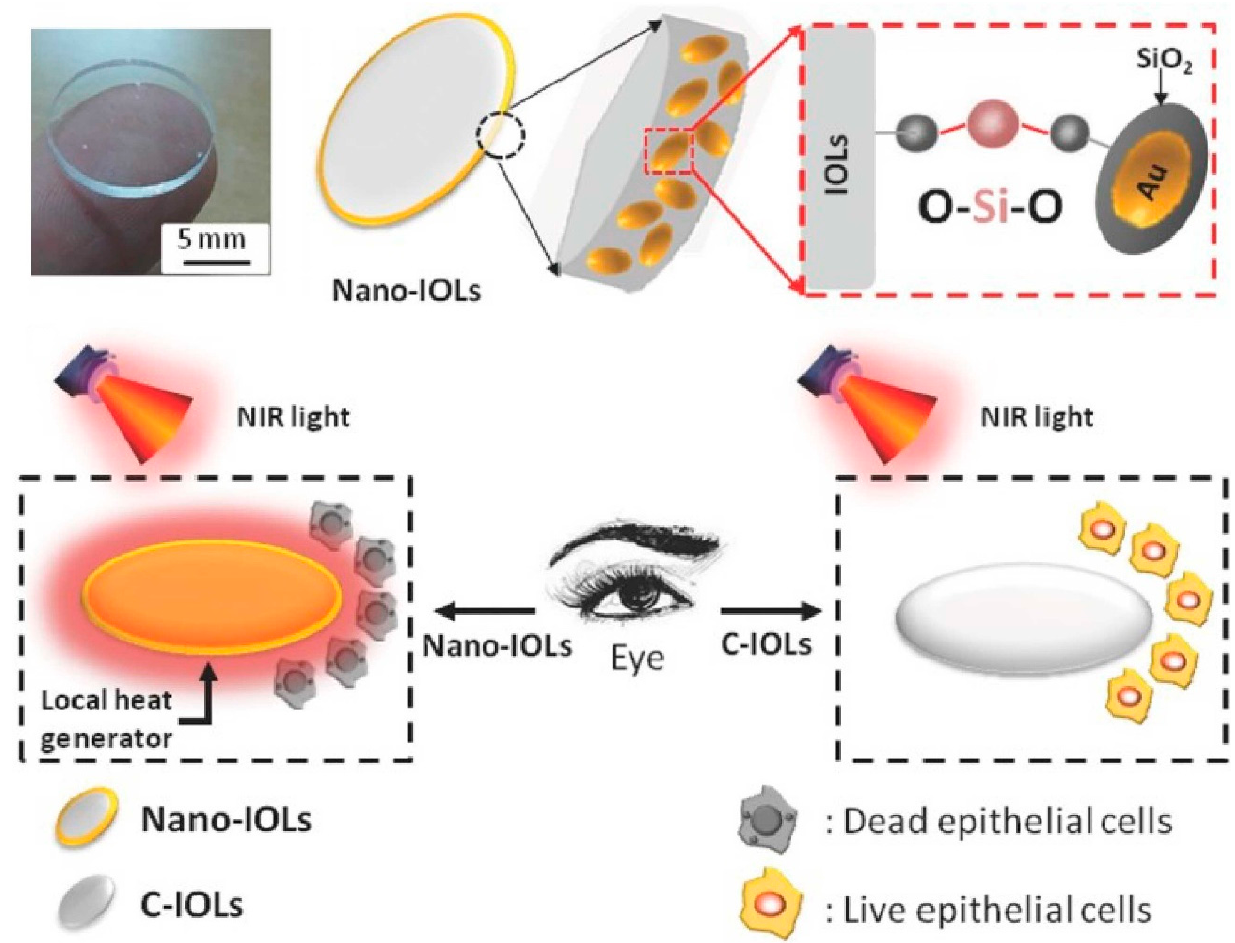
Figure 5. The schematic illustration of nano-IOLs with nanostructured Au@SiO 2 outer rim for prevention of posterior capsule opacification. Adapted with permission from Ref. [76]. Copyright 2017 John Wiley and Sons.